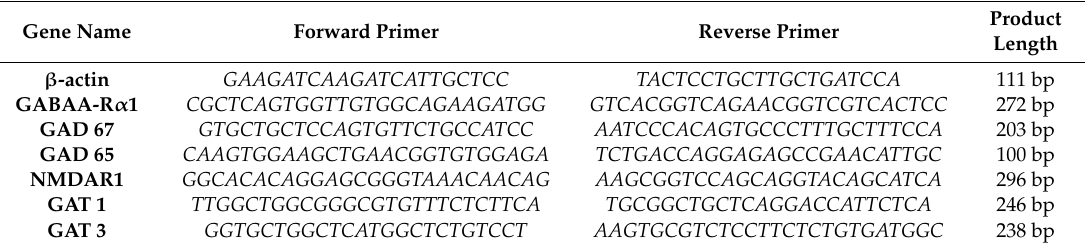
Table 3. Sequence of primers used for